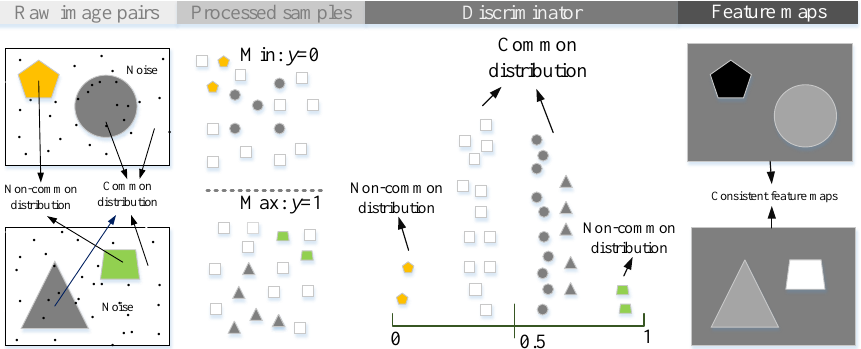
Figure 7. The mapping results of DADNN. During the discriminative process, the white and gray pixel blocks are competing each other between image pairs. The yellow and green pixel blocks have no competition. After several steps of training, the D becomes the optimal, it can identify the yellow and green pixel blocks as coming from image I 1 and I 2 , i.e., D ∗ ( x yellow ) = 0 and D ∗ ( x green ) = 1, respectively. The white and gray pixel blocks cannot be differentiated between the two images by the optimal D ∗ , i.e., D ∗ ( x white & gray ) = 1 . The white and gray areas are common intensity distribution 2 between image pairs. The distances between the common distribution are shrunk. The yellow and green areas are not the common ones. Their distances are